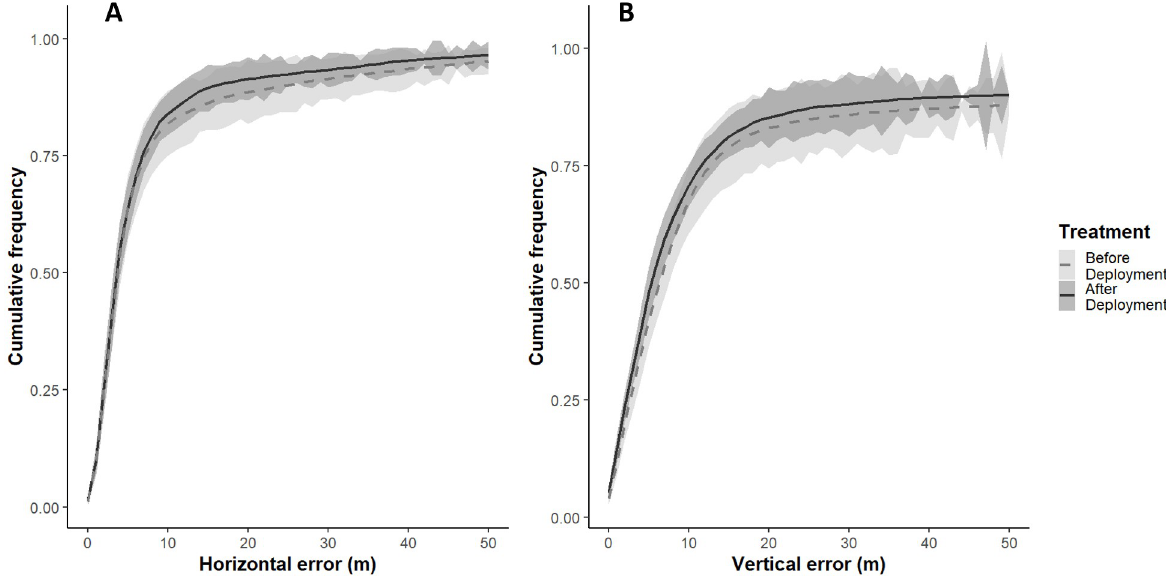
Fig 4. Cumulative frequency of horizontal and vertical accuracy before and after deployment on white storks. Cumulative frequency of (A) horizontal and (B) vertical errors (in m) of 16 GPS/GPRS devices before deployment (grey dashed line) and after deployment on white storks (black line). Shaded areas represent the standard deviation of the